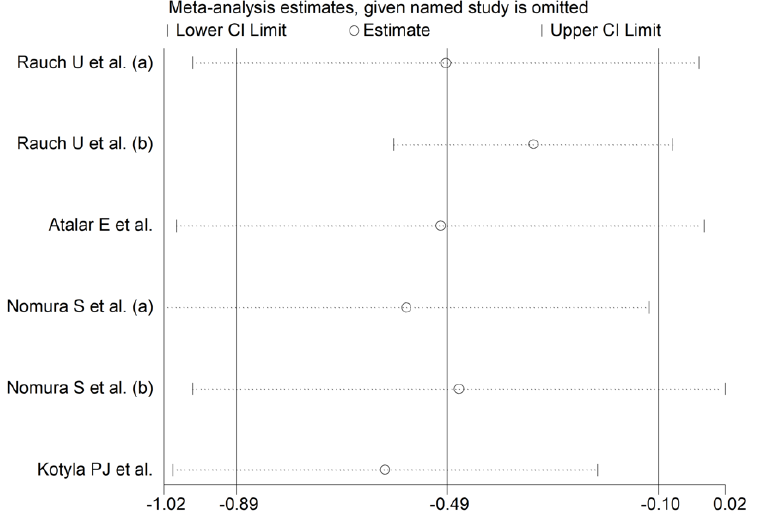
Figure 10. Sensitivity analysis of the association between L-Selectin and statin treatment. The influence of individual studies on the overall standardized mean difference (SMD) is shown. The middle vertical axis indicates the overall SMD, and the two vertical axes indicate the 95% confidence intervals (CIs). The hollow circles represent the pooled SMD when the remaining study is omitted from the meta-analysis. The two ends of each broken line represent the 95% CIs.